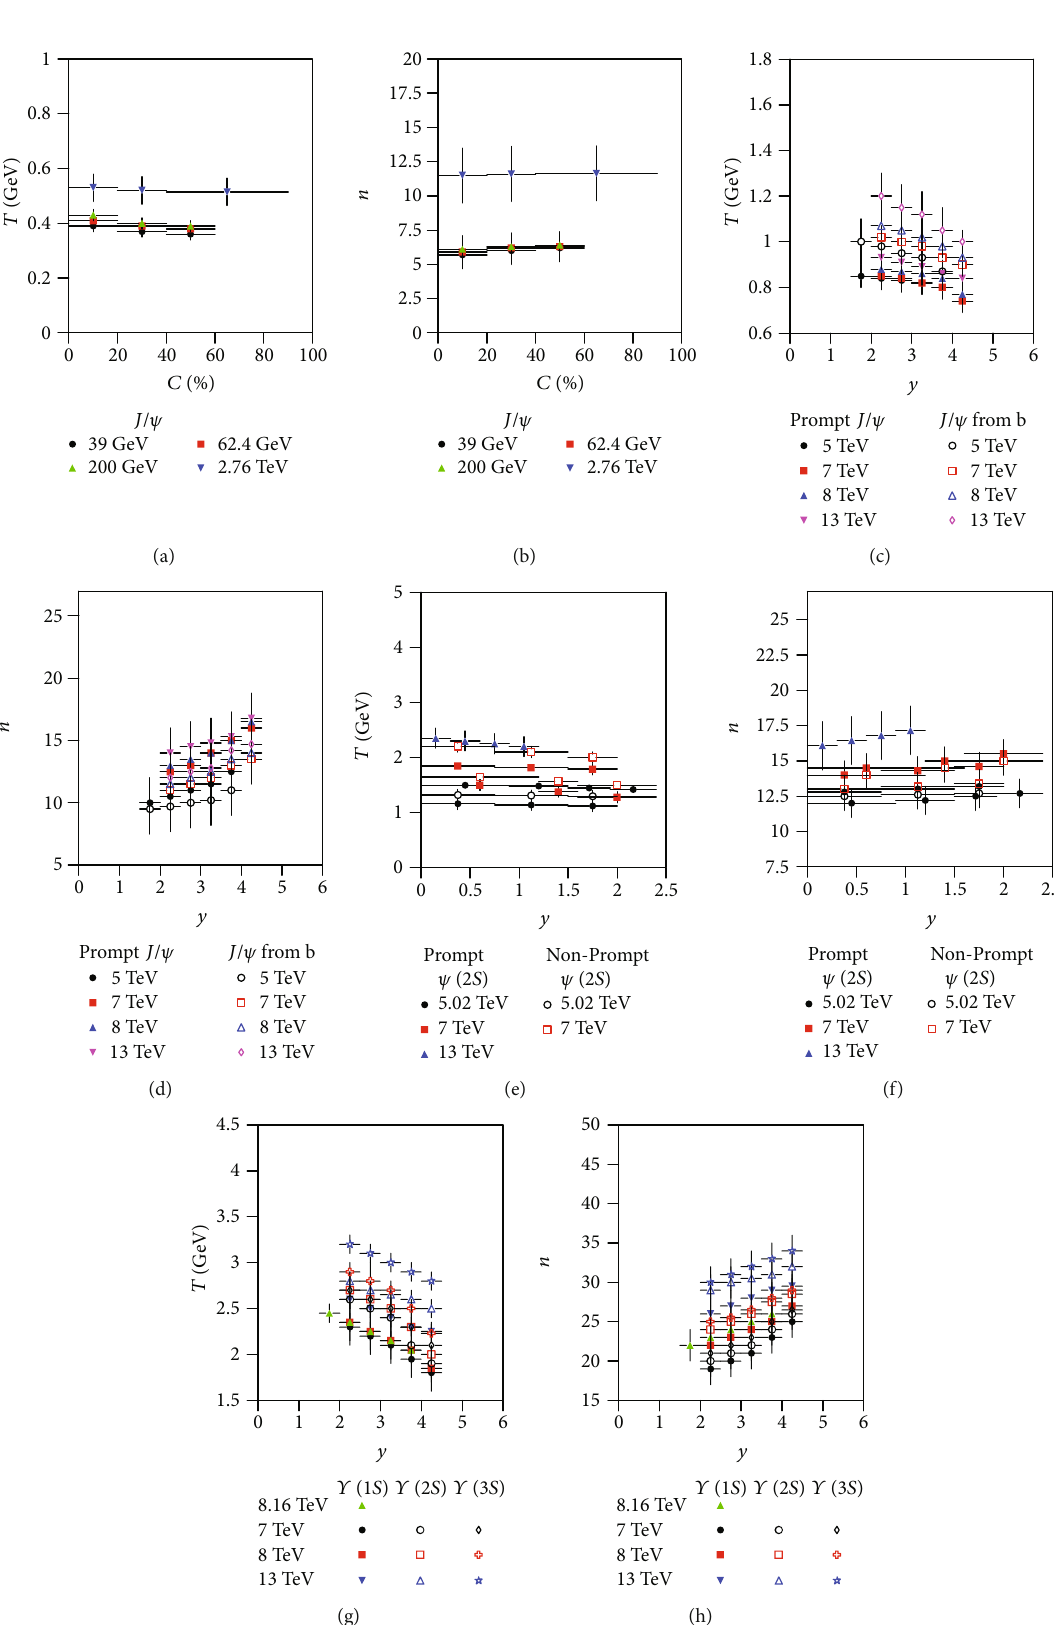
Figure 12: Same as Figure 7, but showing the dependences of (a, c, e, and g) T and (b, d, f, and h) n on (a, b) C and (c – h) y for (a – d) J / ψ , (e, f) ψ ð 2 S Þ , and (g, h) Y ð nS , n = 1, 2, 3 Þ , where T is not the initial temperature, but an e ff ective temperature parameter in the Tsallis-Levy